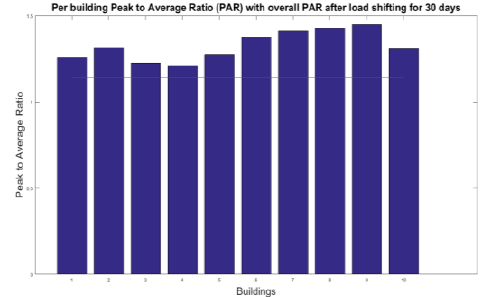
Figure 11. User based PAR with overall PAR after monthly load